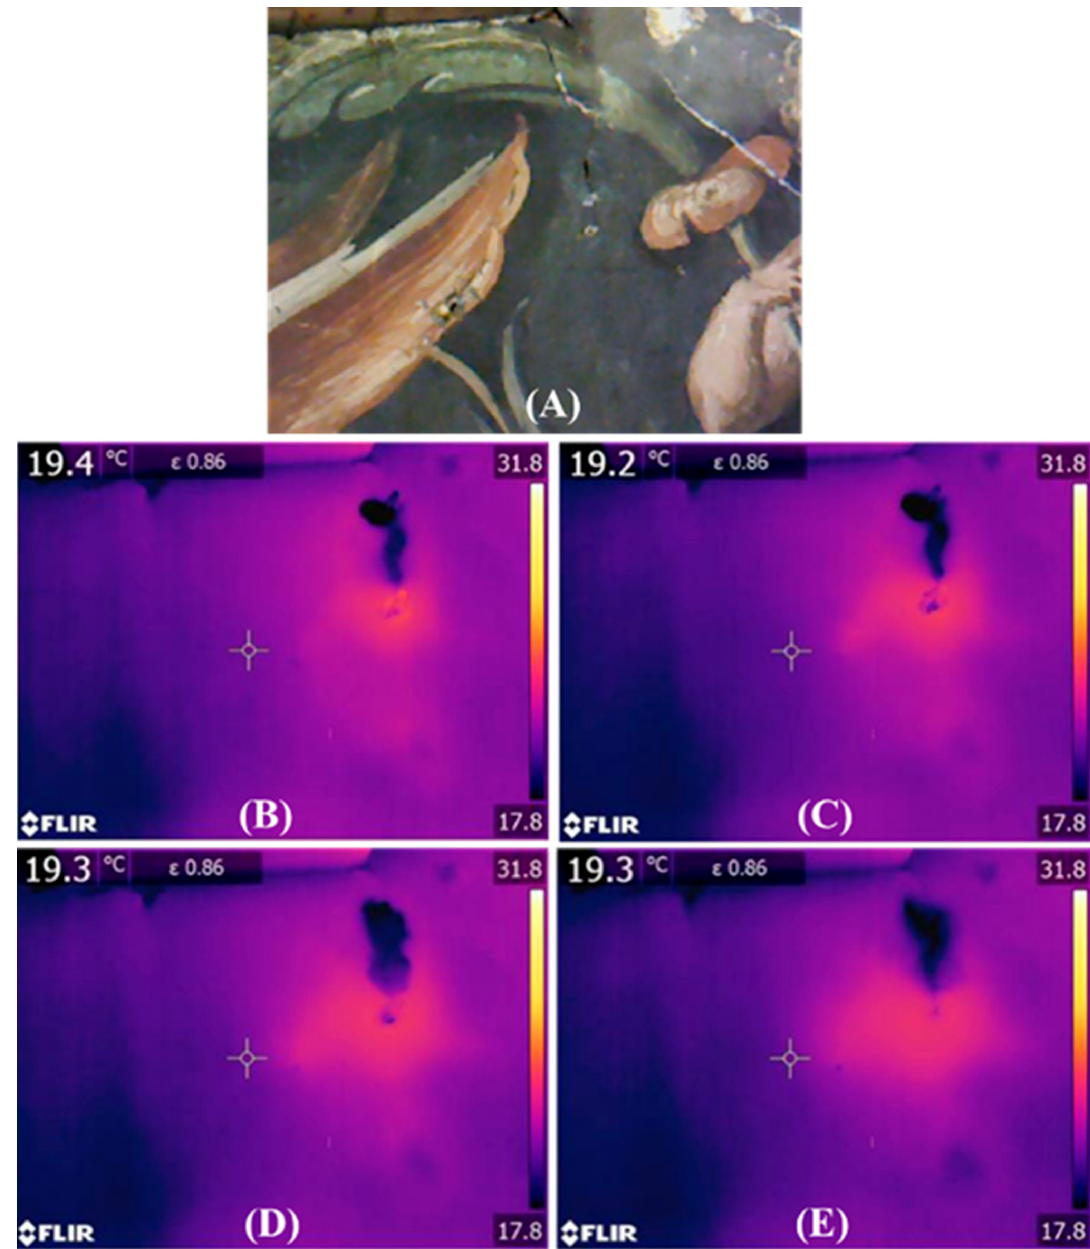
Figure 16. RGB image ( A ) and timeline of thermograms ( B – E ) of the area investigated with passive thermography where the (warmer) Ledan is visible spreading in the preparatory layers after injection by a syringe. Image ( E ) has been taken after 5 min.